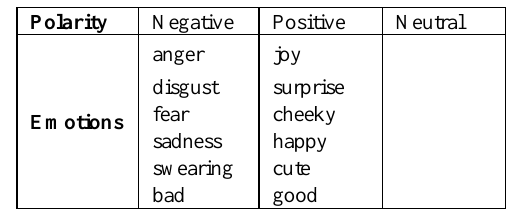
Table 1 . Polarity and emotions that can be extracted by the Gate Cloud Service DecarboNet Environmental